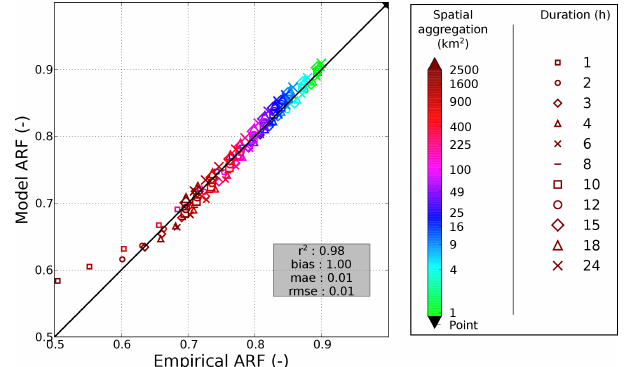
Figure 7. Comparison between empirical ARF (obtained with the regional samples: 30 rain gauges for point resolution and 13 CRs for other spatial resolutions) and the modelled ARF IDAF